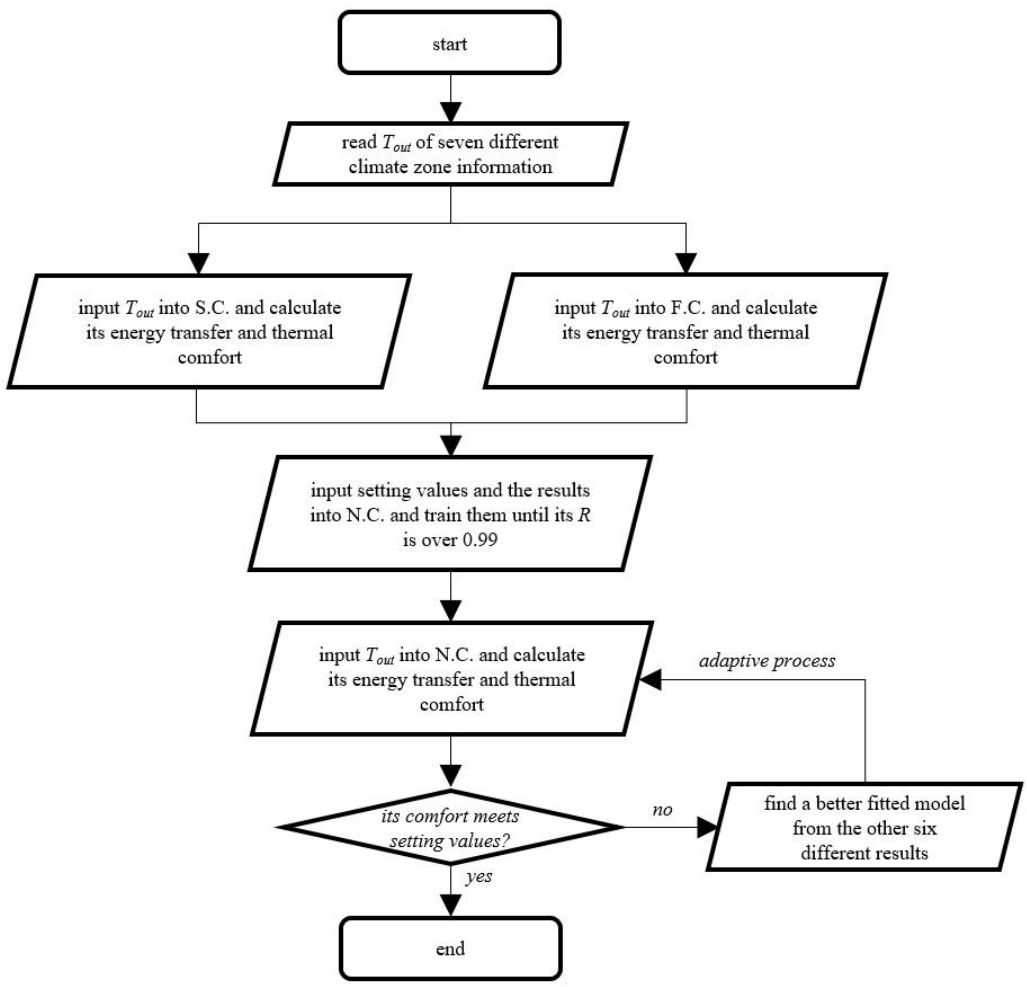
Figure 1. Thermal control design strategy. Table 1. Modeling and simulation